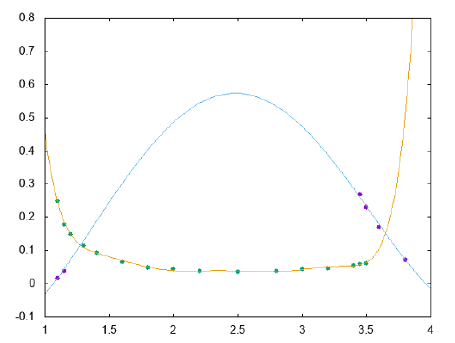
and Figure 12 . The two boundary energies f 1 s f 2 plotted vs. r , for k = 7 in the j = 0 sector. s The critical values of r c are the points of inter- section of the two curves.